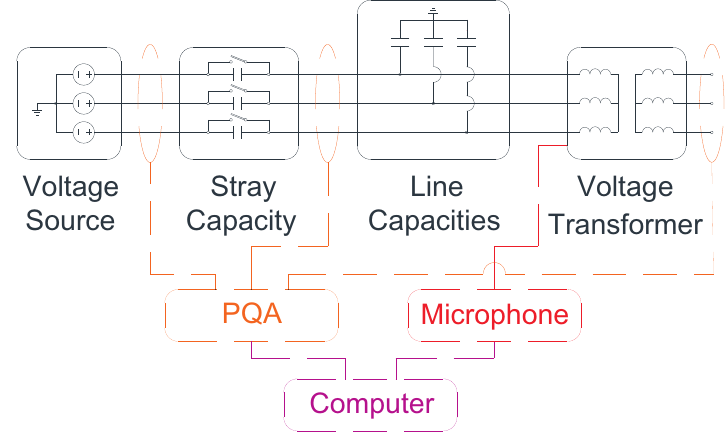
Figure 12. System block diagram.